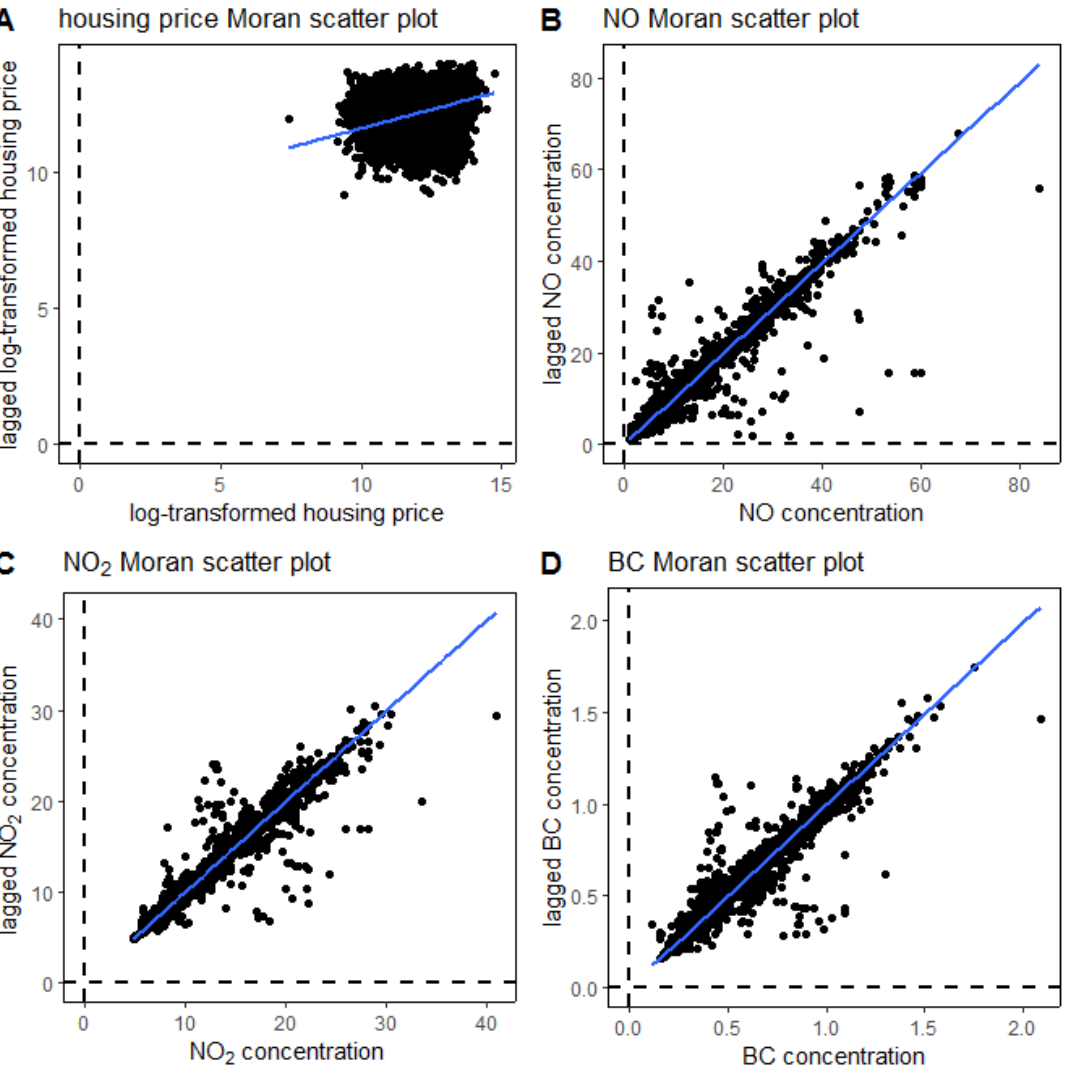
Figure 4. Moran’s I scatter plots of housing prices ( A ), NO ( B ), NO 2 ( C ), and BC ( D ) concentrations (blue lines are the linear regression lines between variables and the lagged variables; the slopes of blue lines are the Moral’s I statistic).